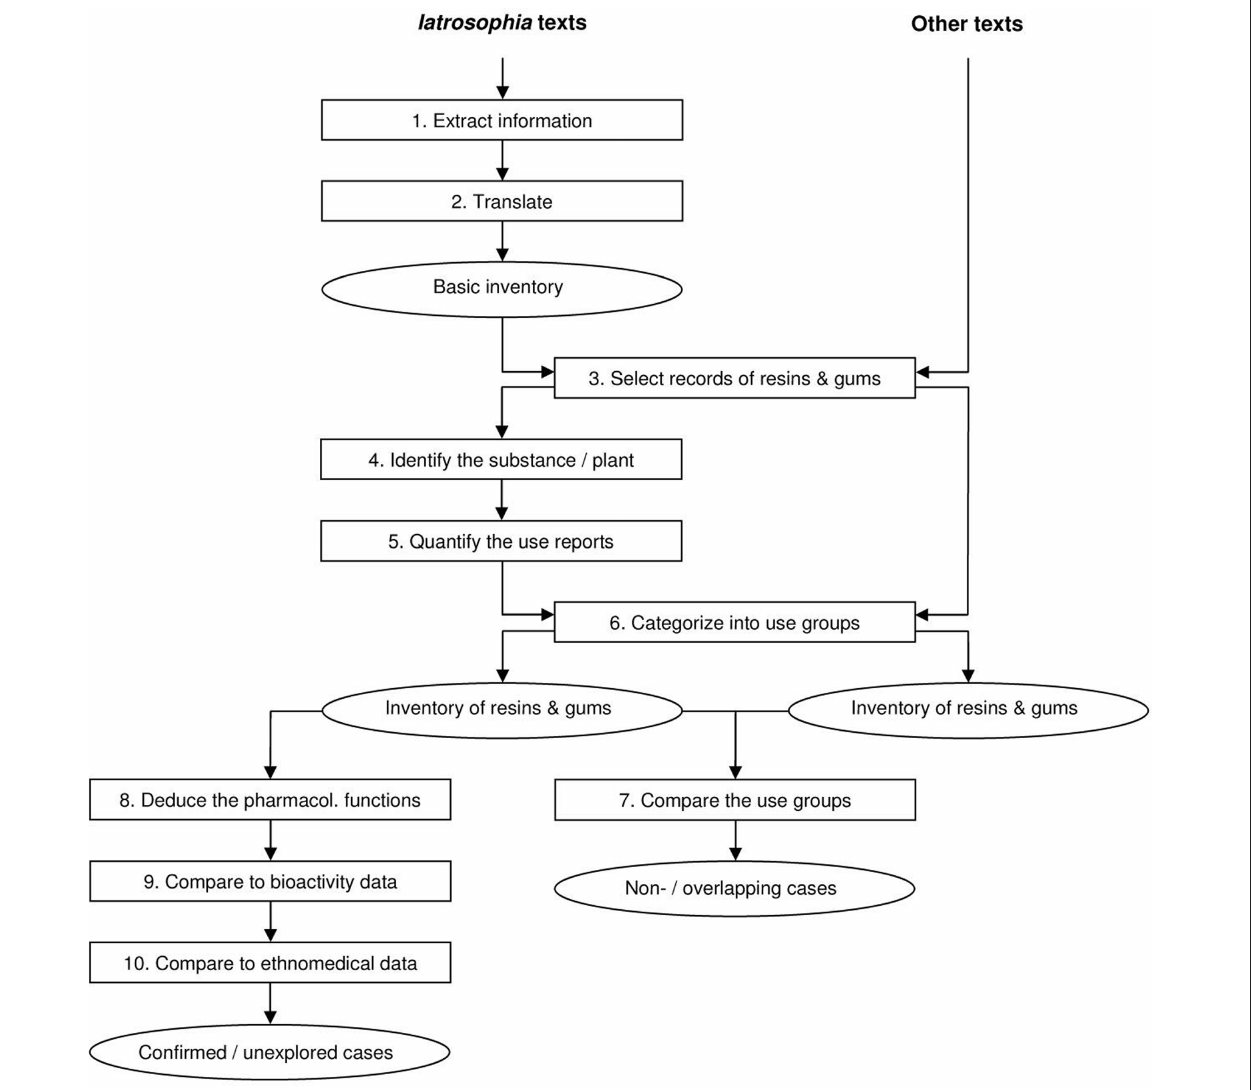
FiguRE 1 | Flowchart of the 10 steps in the analysis of the iatrosophia texts. Steps 3 and 6 were also applied on other texts (i.e., Dioscorides’ De Materia Medica , historic pharmaceutical books and standard texts of modern phytotherapy) and served to establish a separate inventory of resins and gums of their